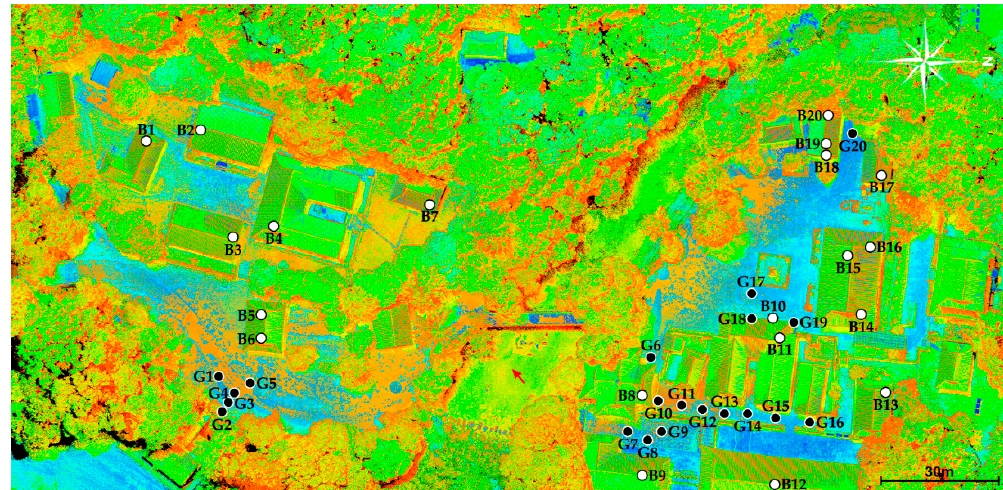
Figure 5. Graphs showing coordinate errors of the terrestrial laser scanning and UAV photogrammetry based on the five ground control points.